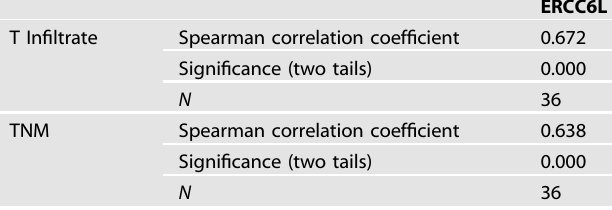
xenografts. Figure 5A showed the fl uorescent pictures of the tumors of mice in each group on day 28. The fl uorescence